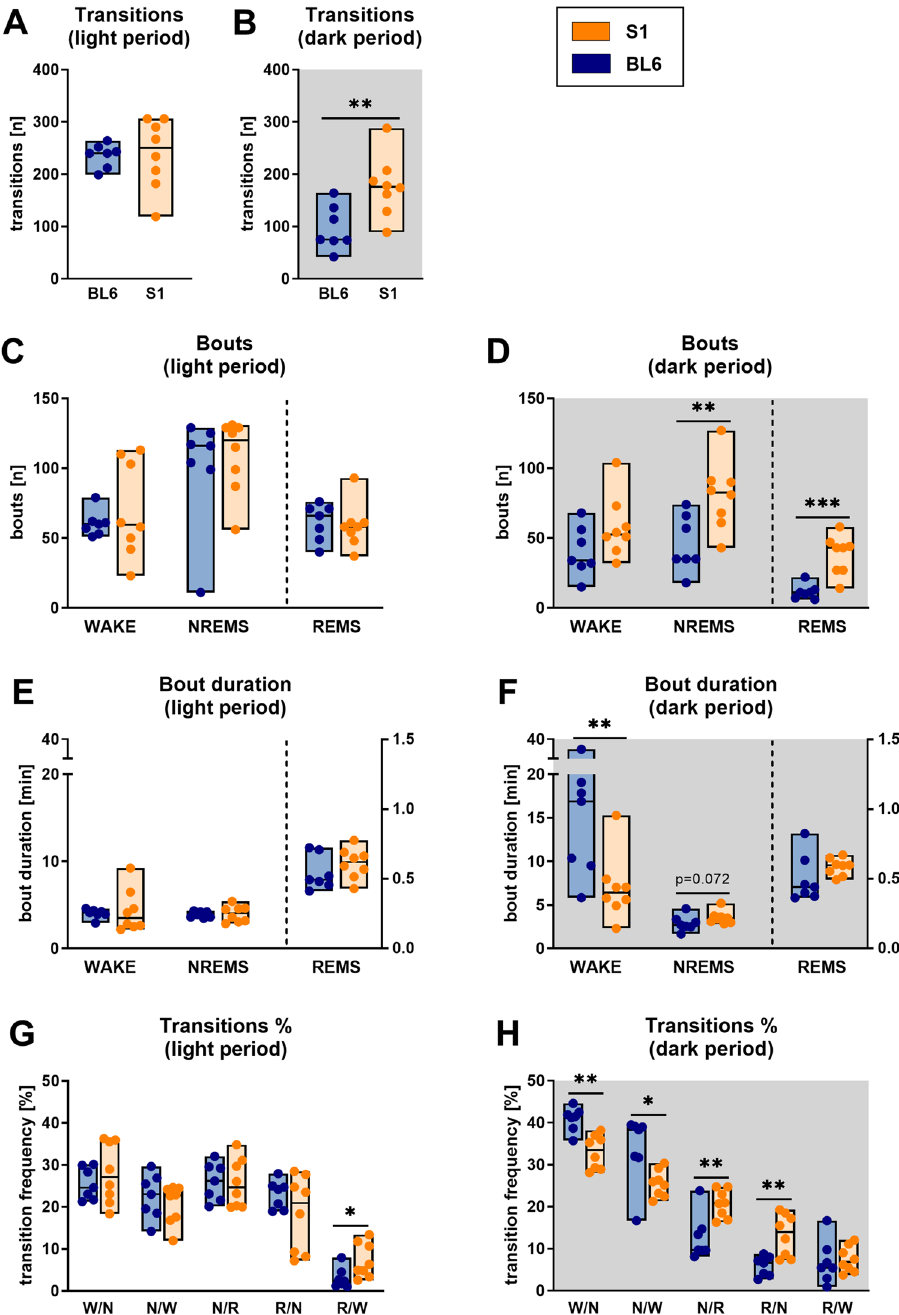
Figure 3. Sleep architecture and fragmentation in S1 (n = 8) compared to BL6 mice (n = 7). Total numbers of transitions were higher in S1 mice in the dark [( A ) p = 0.009], but not the light period [( B ) p = 0.758]. In the light period, bout numbers were comparable to those of BL6 mice [( C) WAKE: p = 0.979; NREMS: p = 0.676; REMS: p = 0.515]. However, S1 mice showed increased numbers of NREMS (p = 0.009) and REMS (p < 0.001), but not WAKE bouts (p = 0.127) in the dark period ( D ). Bout durations during the light period were also similar to those of BL6 controls [( E ) WAKE: p = 0.613; NREMS: p = 0.955; REMS: p = 0.336]. In the active phase ( F ), WAKE bout lengths were significantly decreased in S1 animals (p = 0.009), while there was only a non-significant trend towards longer NREMS bouts (p = 0.072) and no difference in REMS bout lengths (p = 0.121). The percentage of all transitions between WAKE and NREMS and NREMS and REMS were similar in S1 and BL6 mice (W/N: p = 0.613; N/W: p = 0.397; N/R: p = 0.867; R/N: p = 0.463) in the light period ( G ), only the percentage of awakenings from REMS was increased in S1 mice (R/W: p = 0.021). In contrast, S1 mice showed less transitions between WAKE and NREMS (W/N: p = 0.002; N/W: p = 0.021) in the dark period ( H ) while they transitioned more often between NREMS and REMS (N/R: p = 0.009; R/N: p = 0.006) and had similar percentage of REMS-to-WAKE transitions (R/W: p = 0.613) as compared to BL6 mice. All floating bars show min-to-max values with median and individual data points. Statistical significance was determined with a Mann–Whitney U test (*p < 0.05, **p <